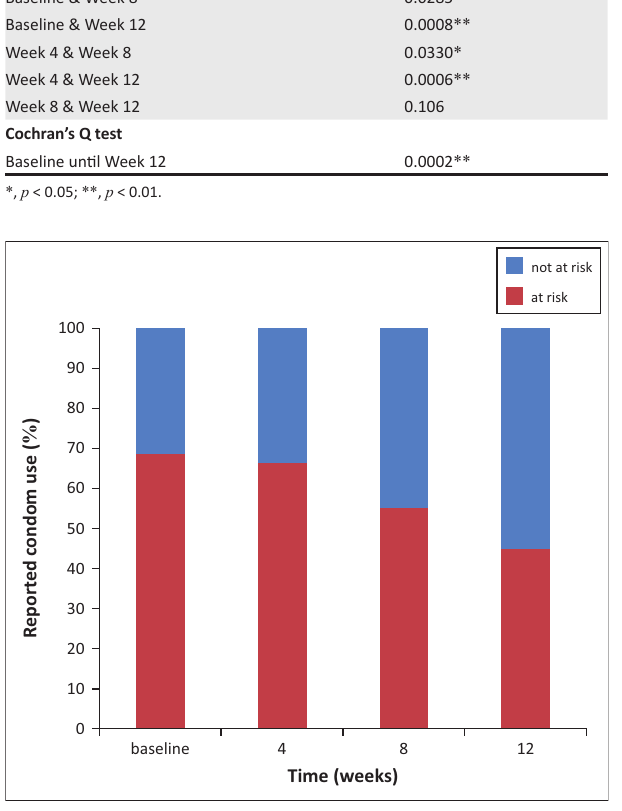
FIGURE 1: Condom migration ( N =